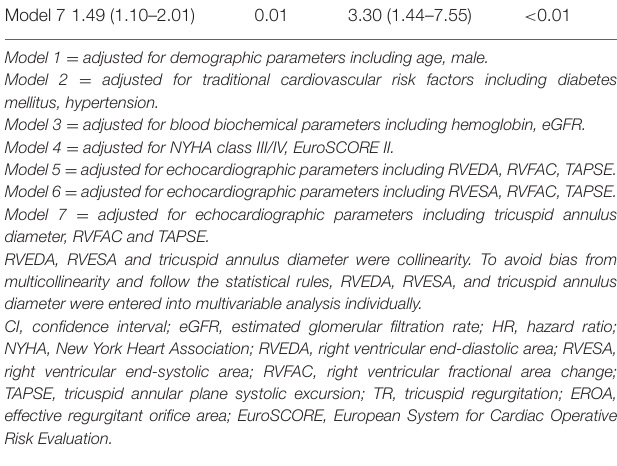
TABLE 2 | Factors associated with long-term adverse events by univariate Cox regression analysis.